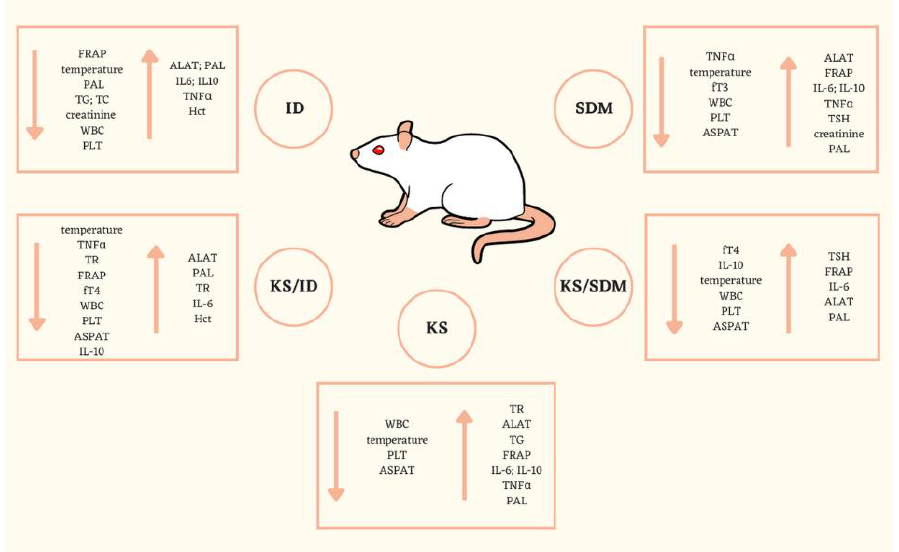
Figure 3. Summary of the main findings (significant changes and tendencies) describing the effect of hypothyroid models and kohlrabi sprouts diet on Wistar rats, see Section 2. for the explanation of the groups’ acronyms and all abbreviations; ↑ increase; ↓ decrease. groups’ acronyms and all abbreviations; ↑ increase; ↓